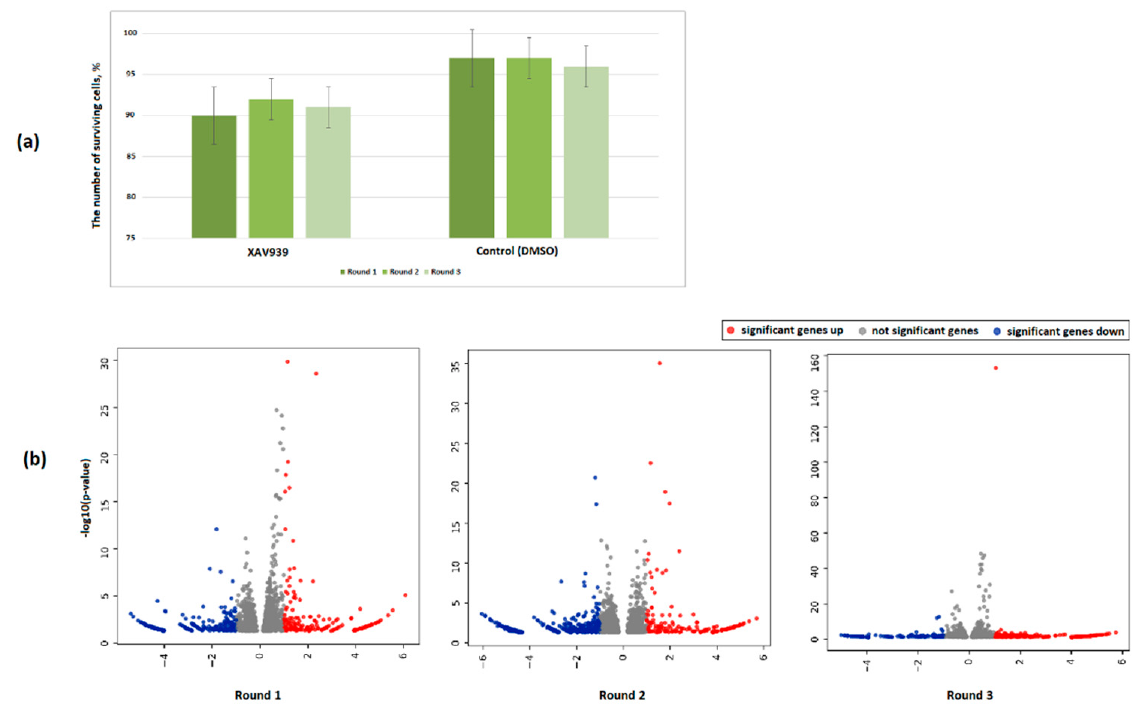
Figure 2. ( a ) The percentage of surviving cells after each round of treatment. The barplots colors reflect the rounds of cell treatments. Cells of similar passages without treatment were taken as 100%. For each round of cell treatment, the average of three experimental replicates is shown. ( b ) Volcano plot of differential gene expression between PC3 cells with sequential XAV939 at 2.5 µM treatments and controls.